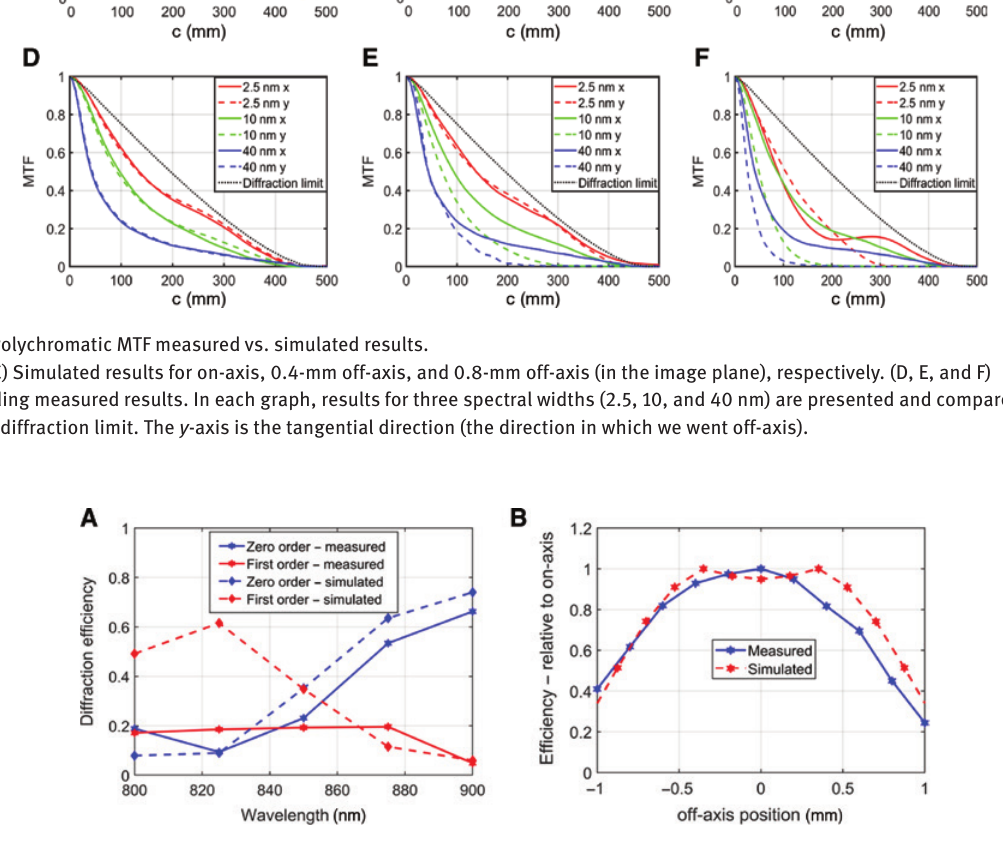
Figure 5: Metalens diffraction efficiency. Measured results compared to simulation. (A) On-axis, first order, and zero order. (B) Off-axis, first order. A distance of 1-mm off-axis in the image plane corresponds to a field angle of 17.3 degrees.